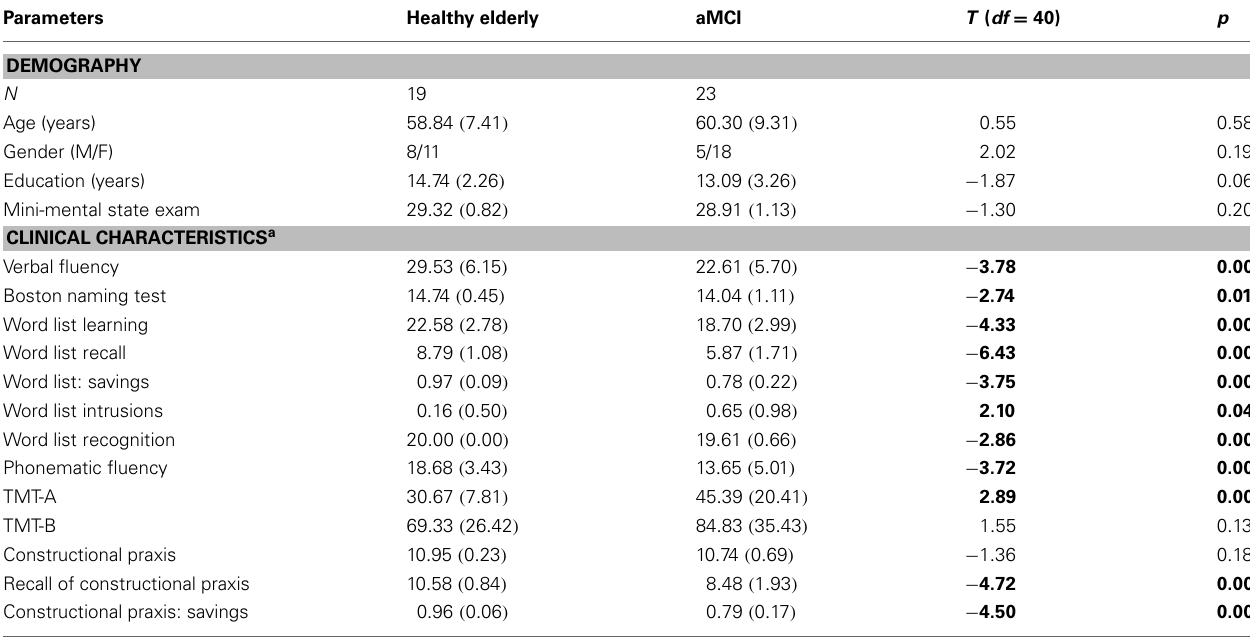
Table 1 | Description of demographic data and results of neuropsychological testing in amnestic mild cognitive impairment (aMCI) and healthy age-matched control